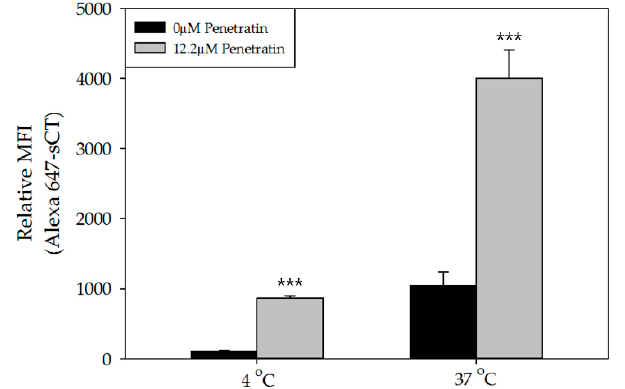
Figure 5. FACS data of FITC-Penetratin and Alexa 647-sCT internalization in TR146 cells. Relative MFI value of Alexa 647-sCT from the group each treated with 0 and 12.2 μ M of Penetratin at 4 °C and 37 °C. All data were represented by mean ± S.D ( n = 3). *** p < 0.001 versus control.